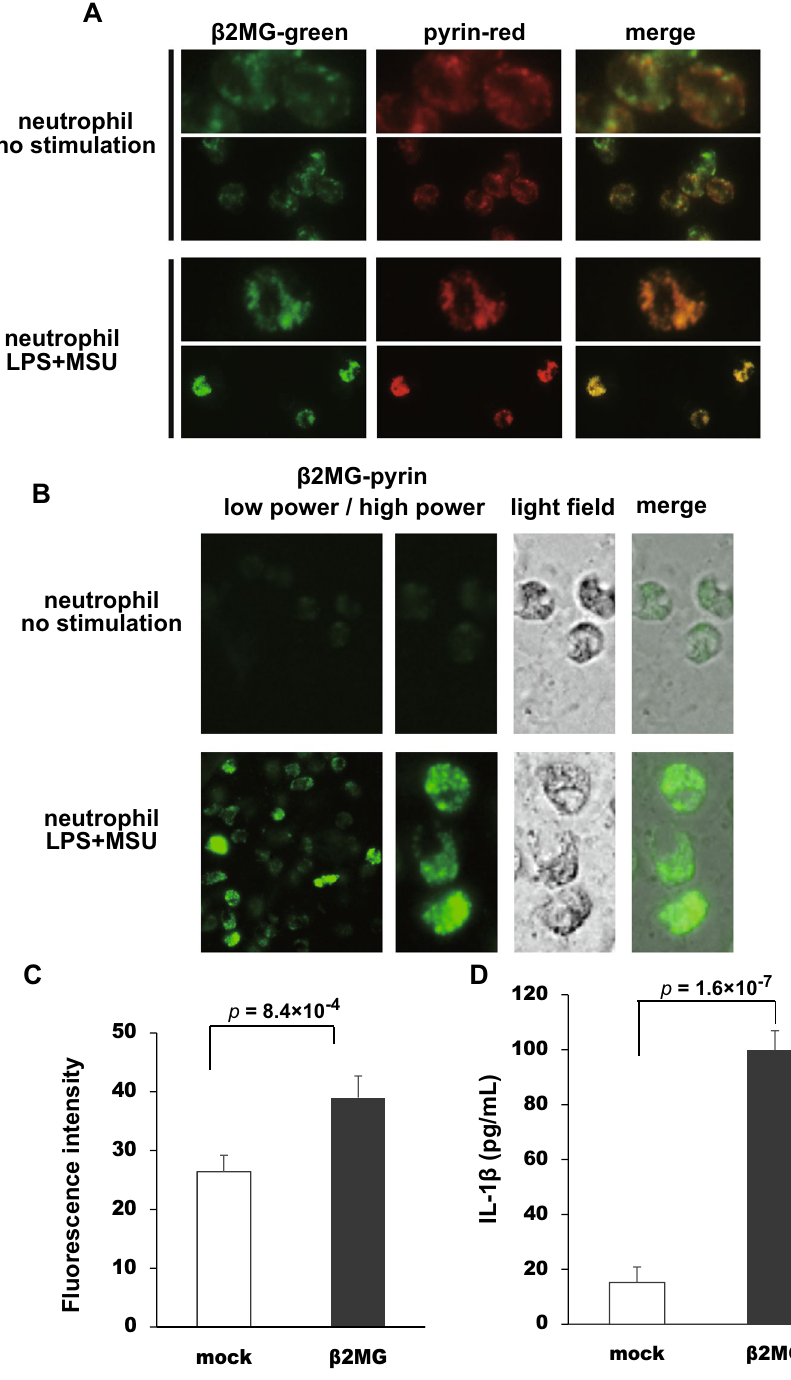
Figure 5. The assembly of pyrin inflammasome leads to caspase-1 activation and IL-1β secretion. ( A ) Human neutrophils stimulated with LPS and MSU crystals were subjected to immunofluorescence staining analyses. Pyrin (red) and β2MG (green) are co-localized in cytoplasm, with forming speck, in the stimulated neutrophils while they are separately localized in cytoplasm and perinuclear granules, respectively, in the unstimulated neutrophils. ( B ) The interaction between pyrin and β2MG was investigated using proximity ligation assay. The microscopic images showed fluorescence signals indicating the pyrin–β2MG interaction in the cytosol of human neutrophils stimulated with LPS and MSU crystals. ( C ) THP-1 cells transfected with mock or V5-β2MG expression vector were subjected to FLICA assay. The overexpression of β2MG in THP-1 cells leads to the stronger capsase-1 activation. Values are the means of nine experiments ± standard error of mean (SEM). ( D ) THP-1 cells transfected with mock or V5-β2MG expression vector were cultured for 24 h, and cell supernatants were subjected to IL-1β ELISA. The overexpression of β2MG in THP-1 cells increases the secretion of IL-1β. Values are the means of six experiments ±